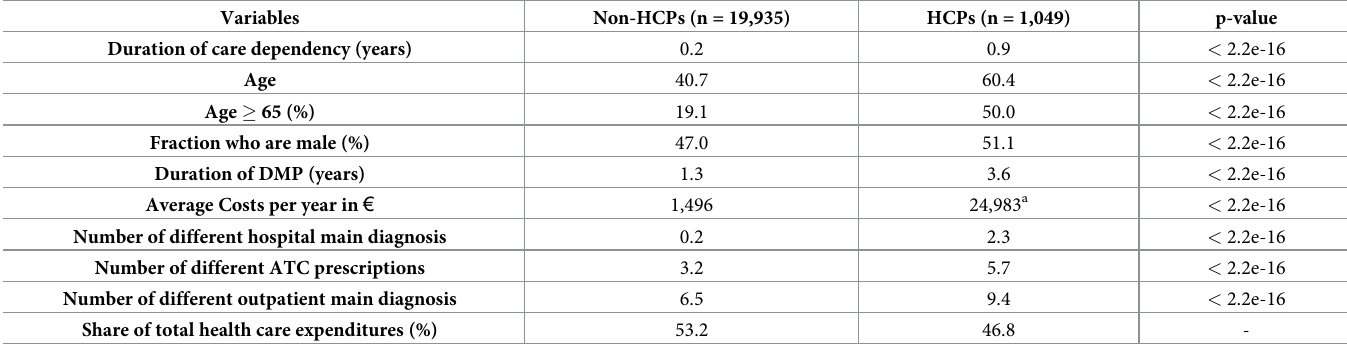
Table 1. Summary statistics of HCPs and non-HCPs, based on a subset of variables and the 2016/2017 dataset.